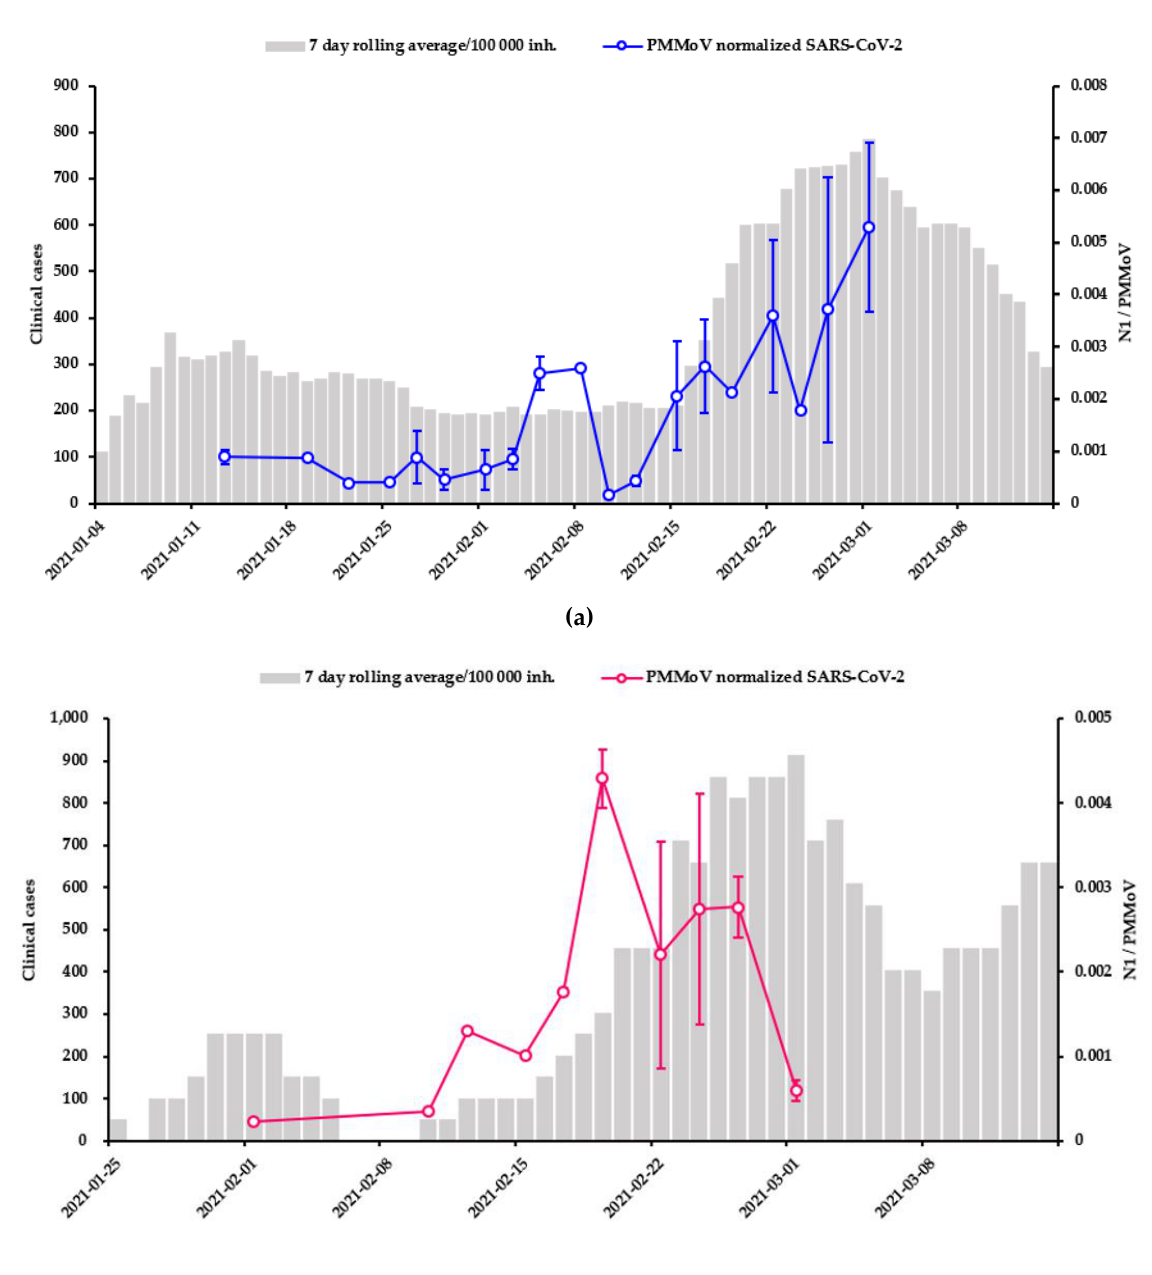
Figure 5. Longitudinal data of PMMoV-normalized SARS-CoV-2 (copies/copies PMMoV) bench- marked with daily new clinical cases based on day of testing at: ( a ) UDD WWTP and ( b ) RAN WWTP. The datemark display is held on the first Monday of every new week. Error bars depict the standard deviation of sampling date replicates.